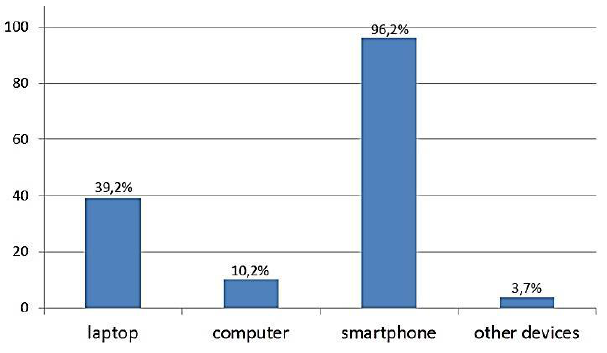
Fig. 1. Students' use of digital gadgets